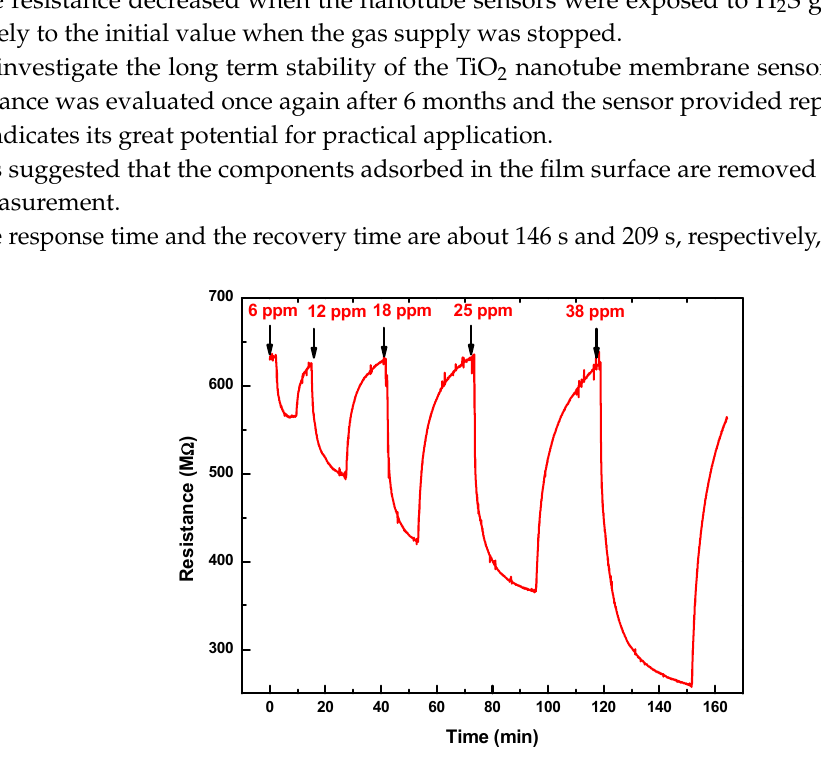
Figure 8. Resistance evolution in presence of several H 2 S concentrations.